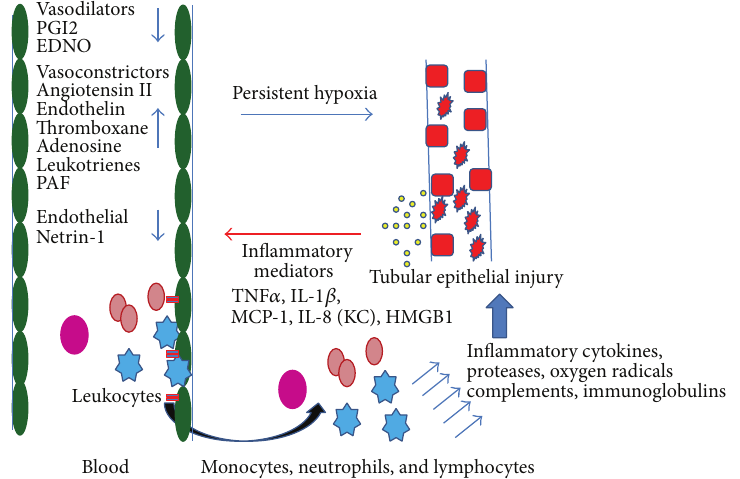
Figure 1: Inflammation in acute kidney injury. Ischemia reperfusion or nephrotoxin causes tubular epithelial stress or necrosis which releases inflammatory mediators. These inflammatory mediators activate endothelial cells and expression of adhesion molecules (II) such as ICAM- 1 induces leukocyte migration into the interstitium and release of vasoconstrictor. At the same time inflammation downregulates anti- inflammatory molecules such as netrin-1 and endothelial nitric oxide. Infiltrated white blood cells such as neutrophils, monocyte, and T cells release cytokine, chemokines, proteases, and oxygen radicals cause further damage to the epithelium. All these events lead to vasoconstriction and persistent hypoxia which contributes to further tissue